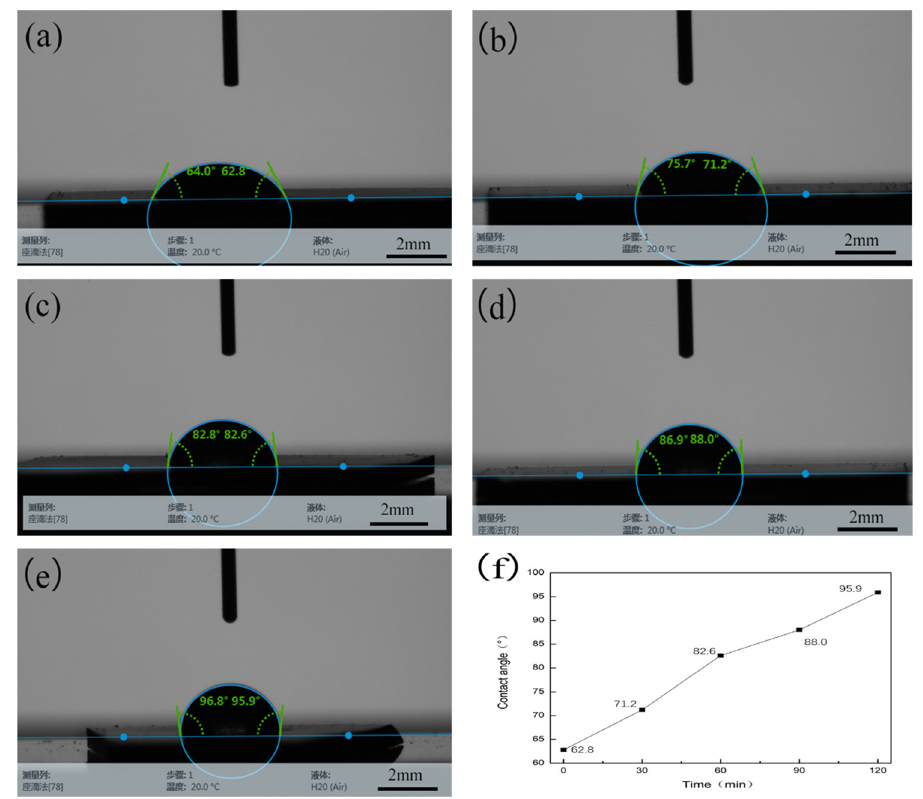
Figure 6: Diamond fi lm contact angle test results: ( a ) 0, ( b ) 30 min, ( c ) 60 min, ( d ) 90 min, ( e ) 120 min, and ( f ) contact angle variation curve with